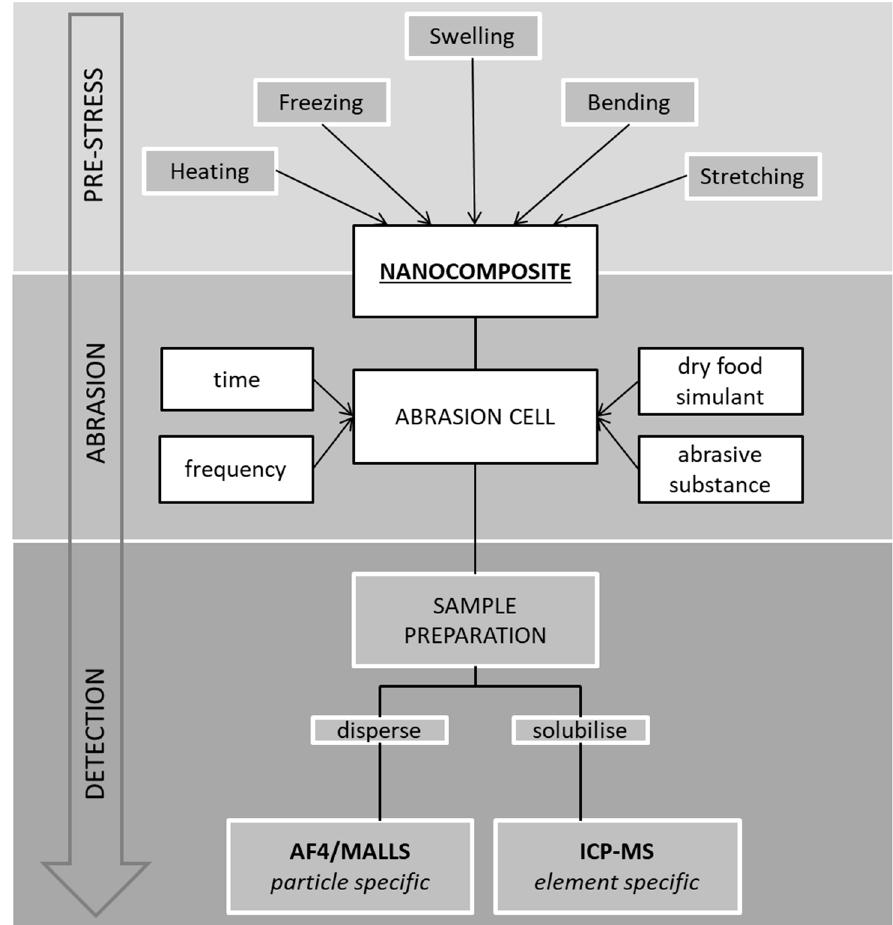
Figure 1. Schematics of the mechanical nano-release test procedure.